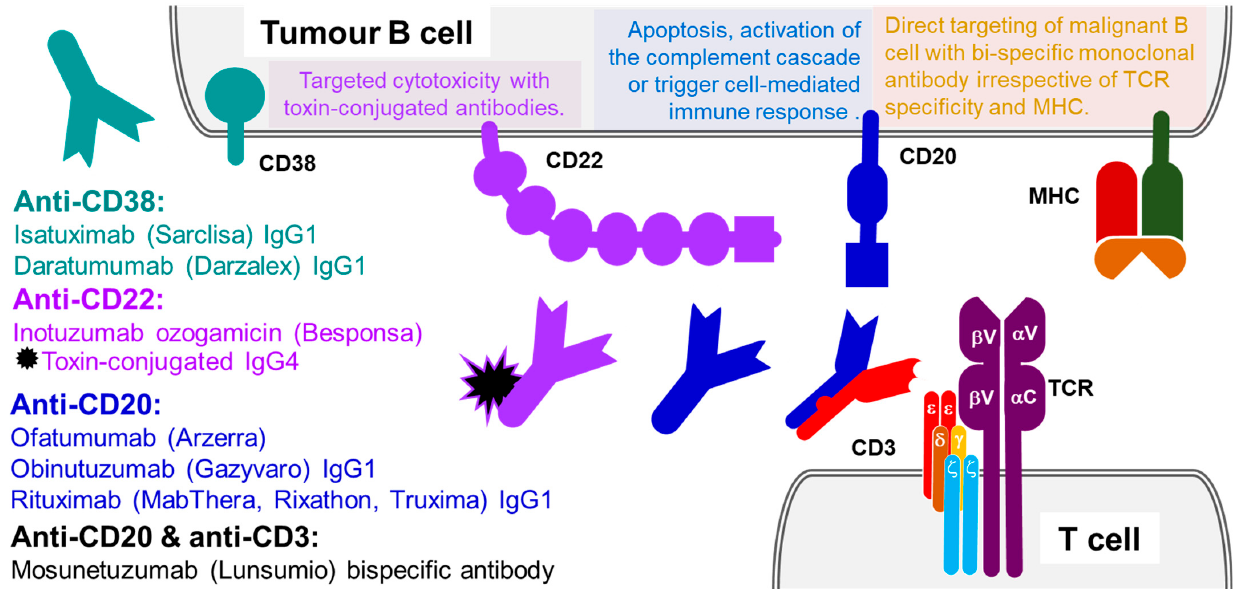
Figure 3. Antibody therapeutics targeting B-cell and T-cell antigens. Targeting tumour B-cells with unconjugated monoclonal antibodies against ADP-ribosyl cyclase/cyclic ADP-ribose hydrolase 1 (protein CD38, coloured teal) or unconjugated monoclonal antibodies against B-lymphocyte antigen CD20 (coloured blue). Targeting tumour B-cells with monoclonal antibodies against B-cell receptor CD22 conjugated to a cytotoxic antibiotic N-acetyl-gamma-calicheamicin dimethylhydrazide (coloured purple). Bispecific antibody simultaneously targets B-lymphocyte antigen CD20 and CD3 epsilon subunit of the CD3-TCR complex on T-cells (coloured in blue-red), and redirects polyclonal cytotoxic T lymphocytes toward the tumour.